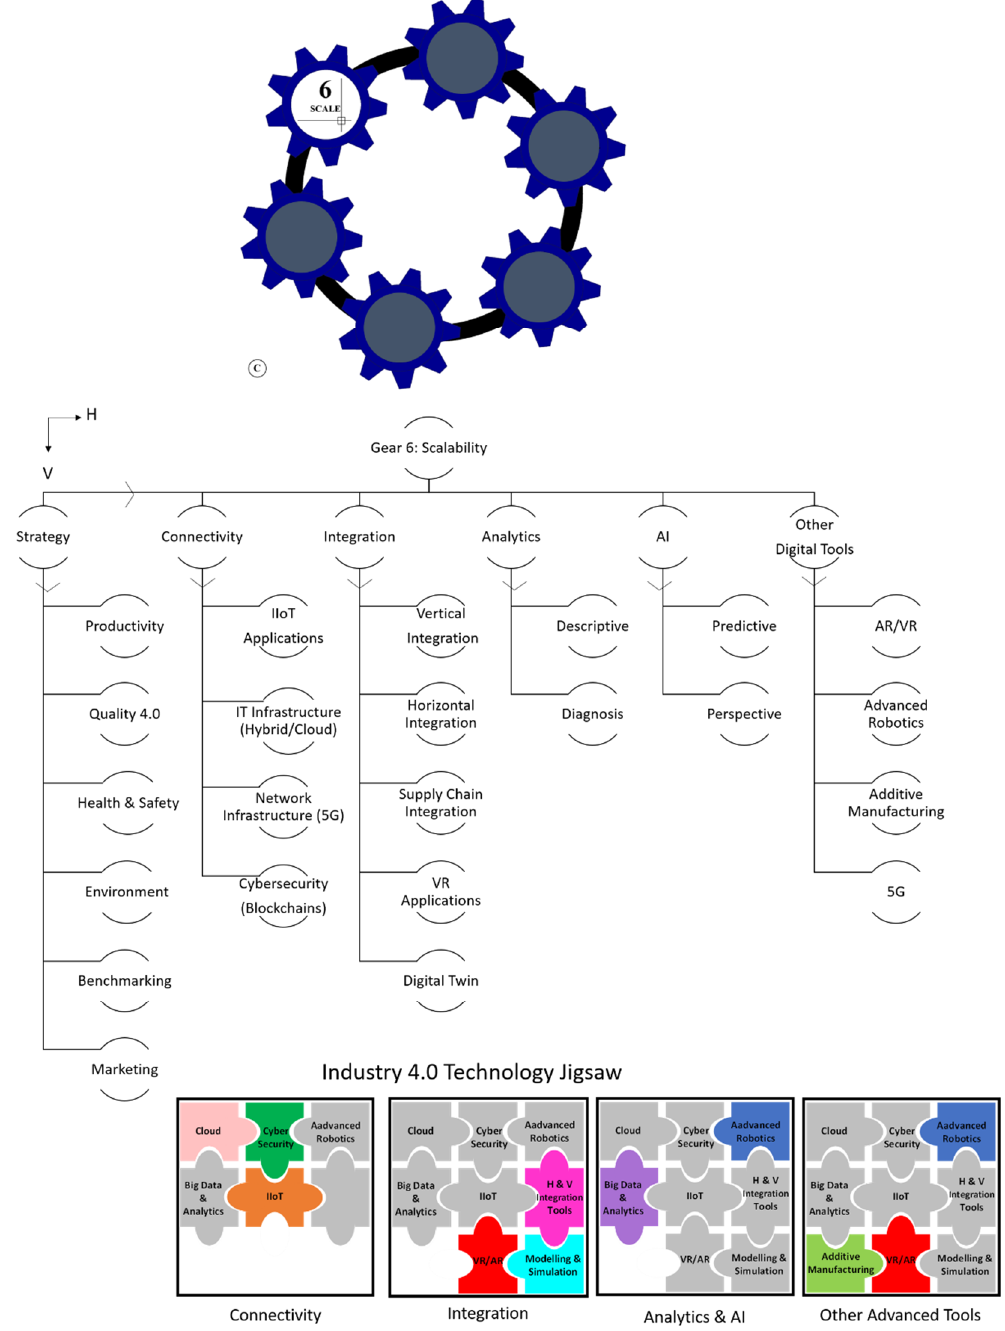
Figure 13. Gear 6—scalability stage and Industry 4.0 technology jigsaws (primary technologies represented in color, sec- ondary technologies represented in grey).